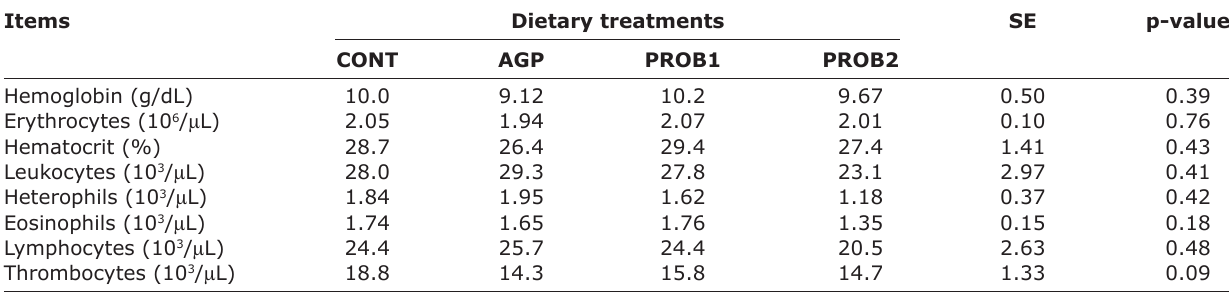
Table-4: Effect of multi-strain probiotic preparation in combination with vitamins and minerals on complete blood counts of the Indonesian indigenous crossbred chickens. Items Dietary